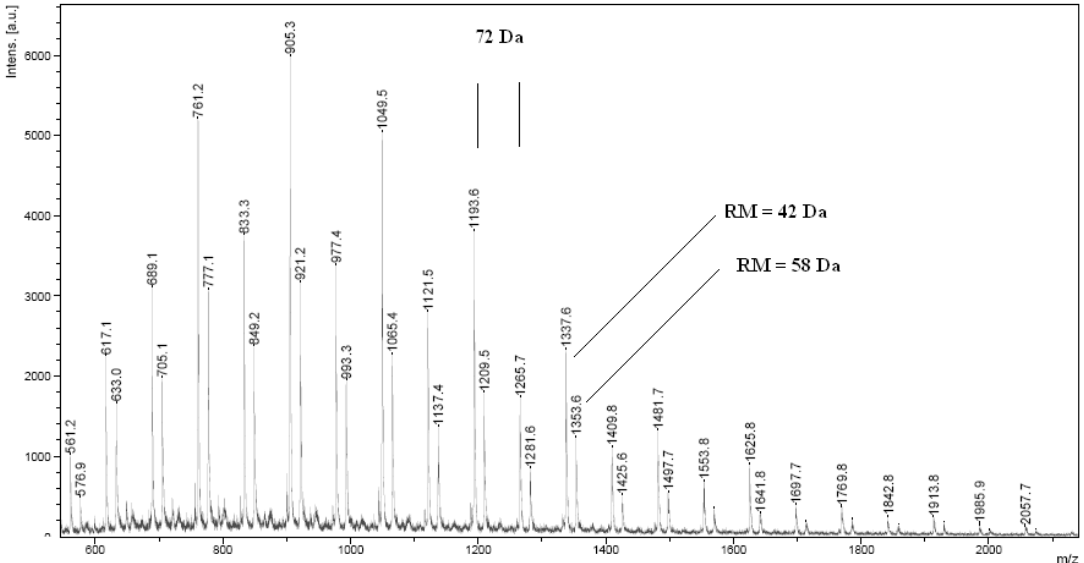
Figure 2. The MALDI TOF spectrum of the product of L -LA polymerization in the presence of CE (Table 1, run no.